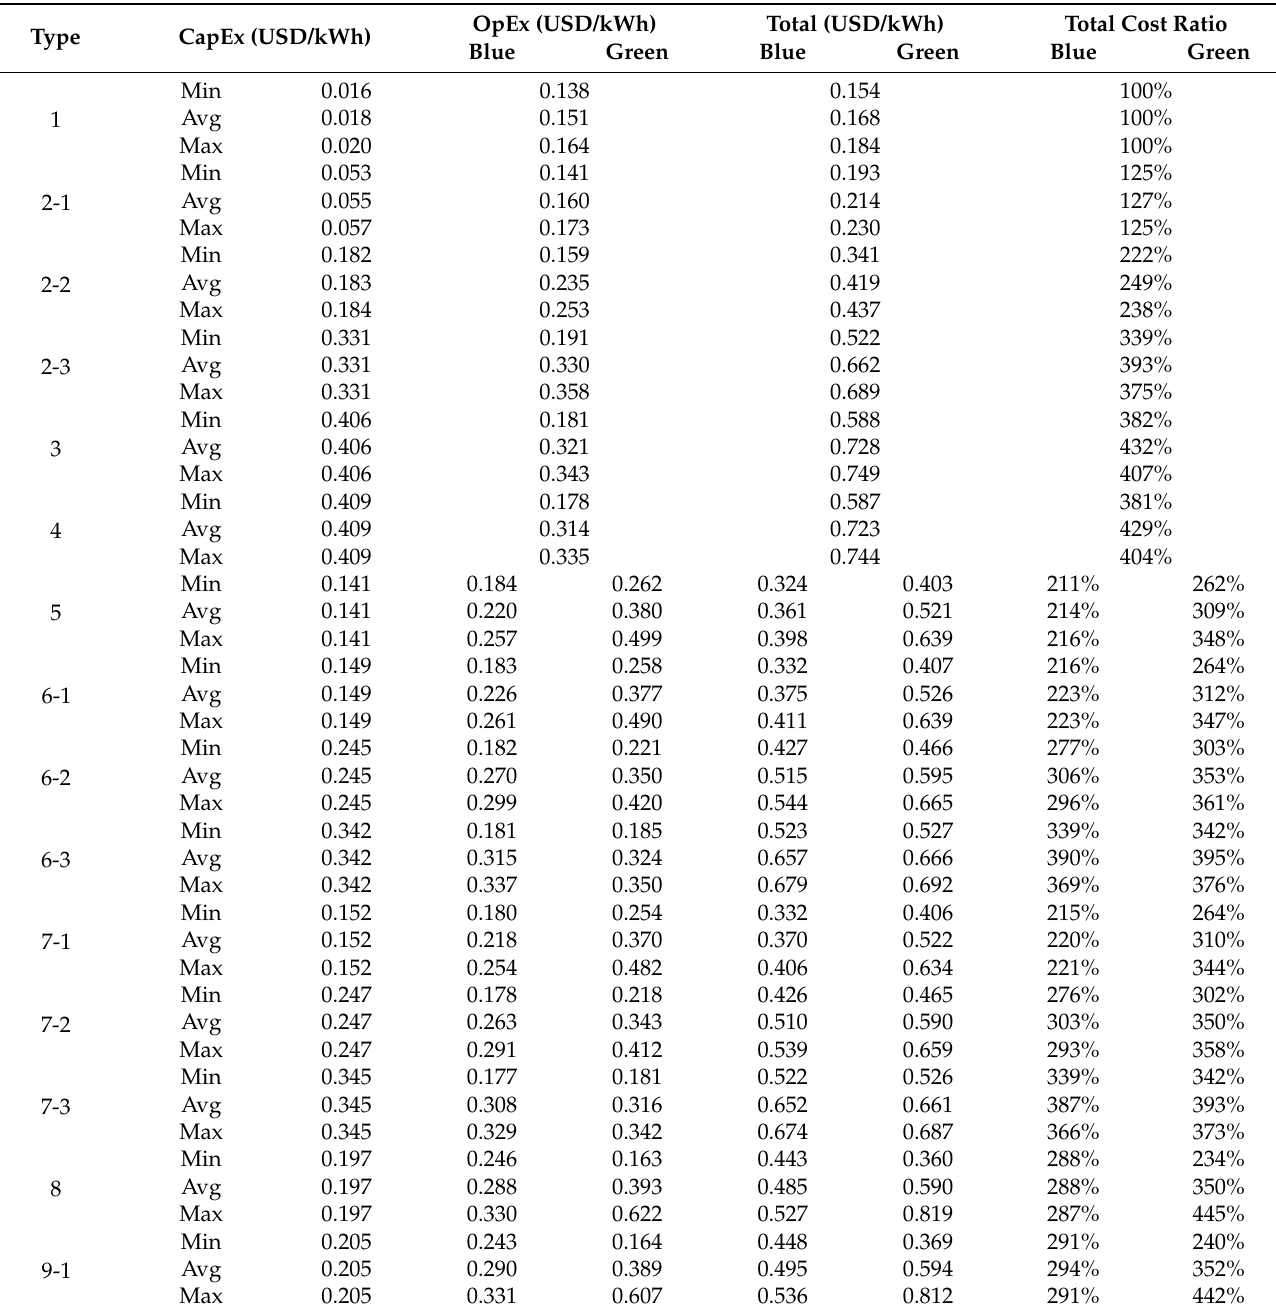
Table 7. Levelised cost of each type for ships excluding fuel